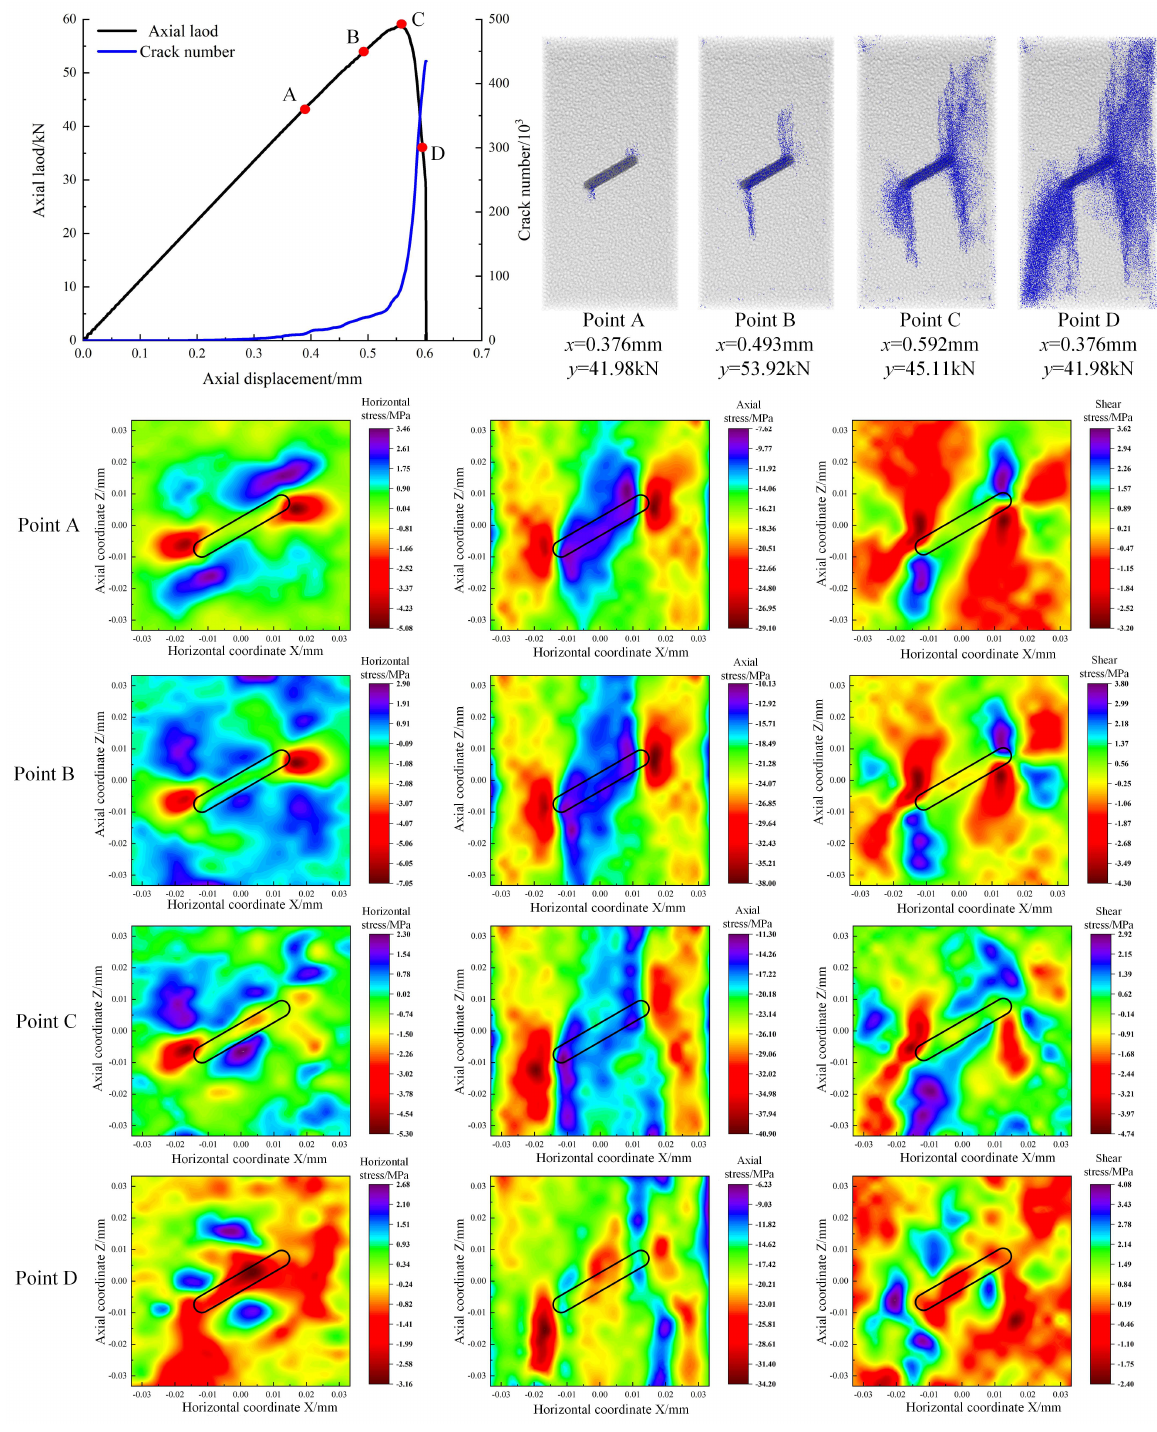
Figure 17. Crack propagation and stress evolution of N−30 sample.